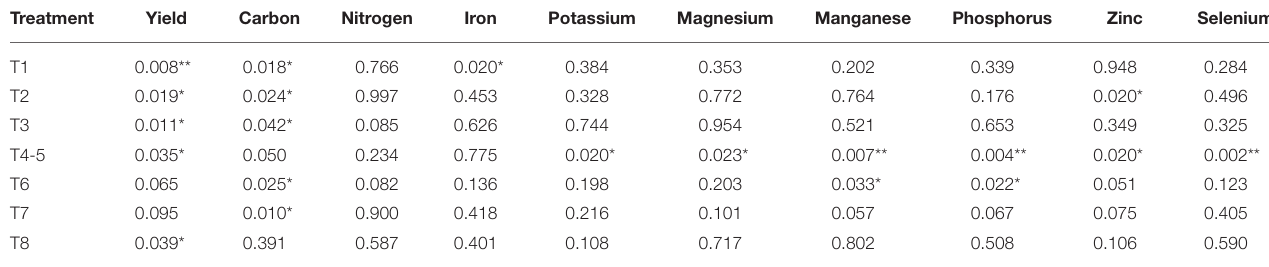
TABLE 3 | P -values and significance of year-to-year variation in maize grain yield and mineral content between the 2018–19 and 2019–20 conservation agriculture trials. Treatment Yield Carbon